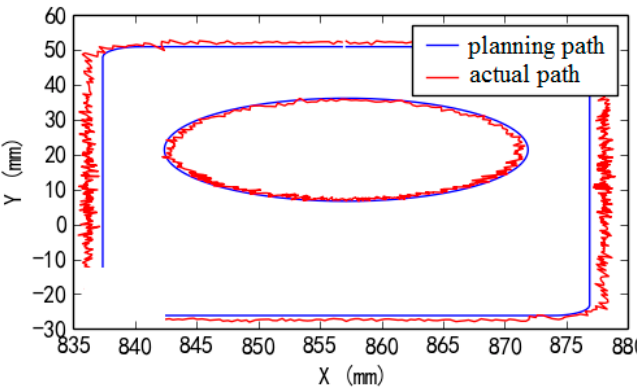
Figure 28. Experimental deburring results for multifaceted edges of automobile steering booster housing: ( a ) top facet; ( b ) distal side facet; ( c ) proximal side facet.